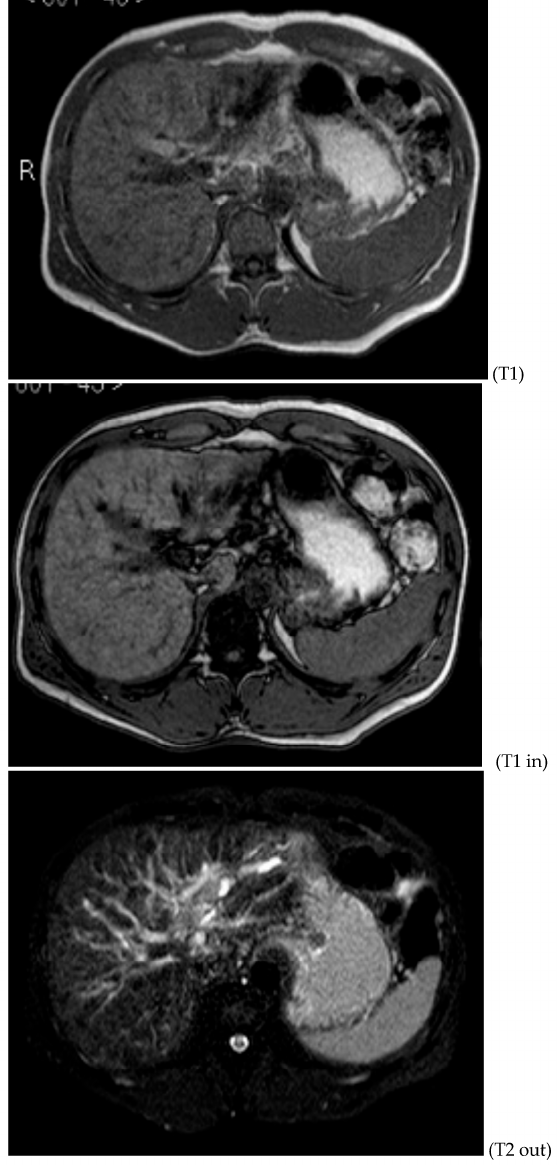
Figure 4. MRI T1, T1 in, T1 out, and DWI.